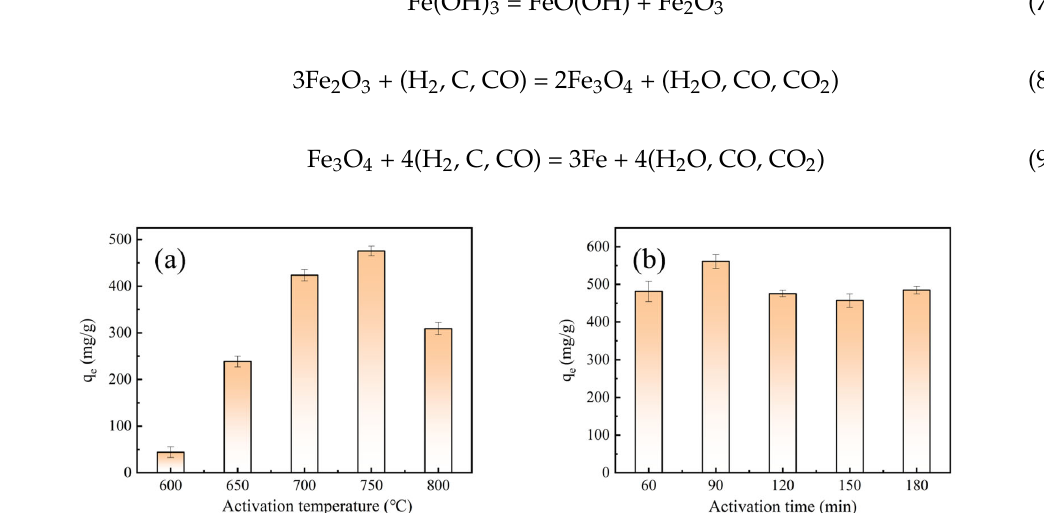
Figure 1. Adsorption capacities of the BACs in relation to ( a ) activation temperatures and ( b ) activation times.